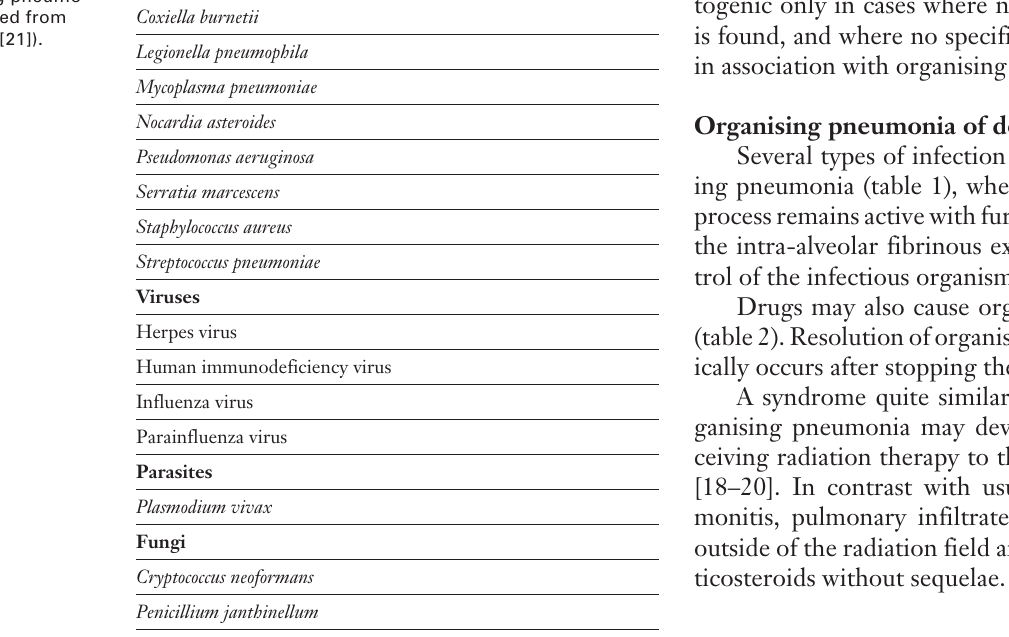
Infectious causes of organising pneumo- nia (adapted from reference